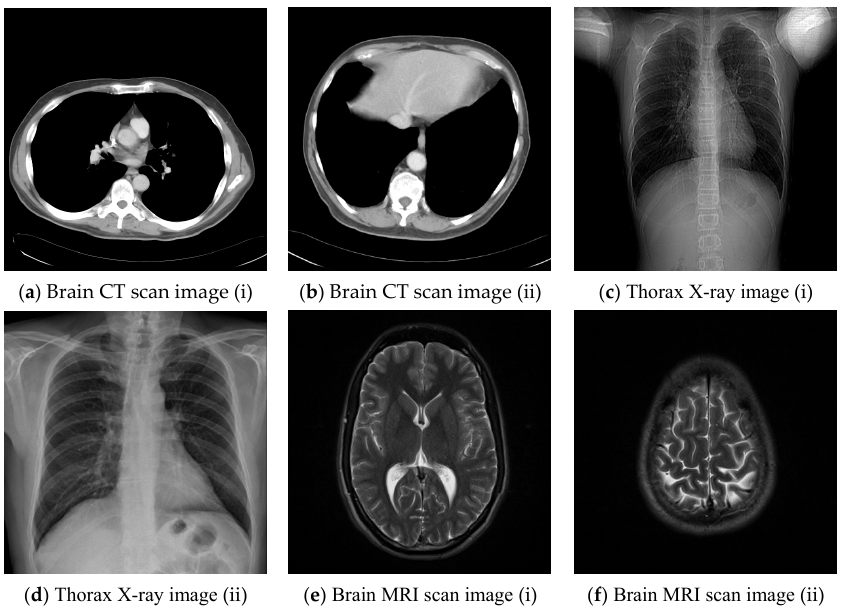
Figure 10. Six medical test images; ( a ) Brain CT scan image (i); ( b ) Brain CT scan image (ii); ( c ) Thorax X-ray image (i); ( d ) Thorax X-ray image (ii); ( e ) Brain MRI scan image (i); ( f ) Brain MRI scan image (ii).